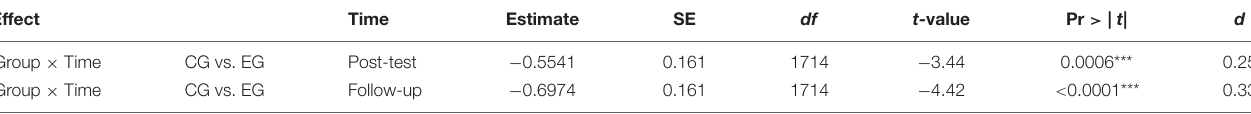
TABLE 2 | Comparisons of group × time least-squares means by simultaneously considering all dependent variables.